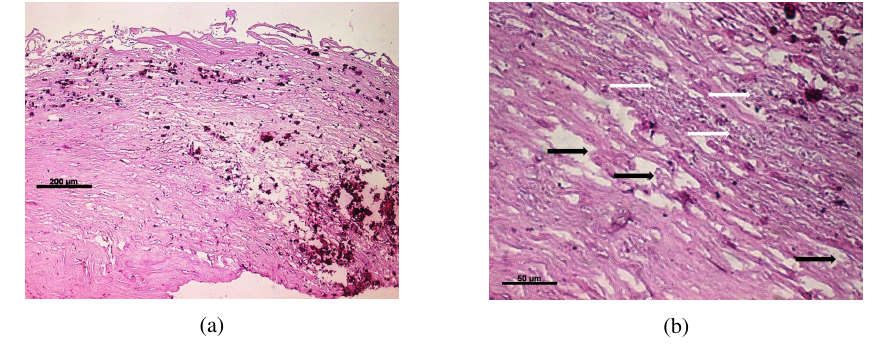
Figure 3: Cross-section of the arterial wall aneurysm (dome). (a) – the presence of large foci of calcification (bright black and purple blotches), as well as zones of calcification dif- fuse around the primary focus. (b) – microfragmentation of artery wall structures (white arrows). Fiber breaks and defects (black arrows) in the stroma of aneurysm wall. Stained with hematoxylin-eosin.